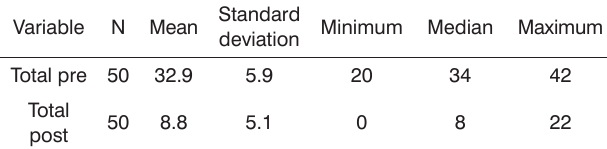
Table 1. Descriptive statistics for total HHIE scores before and after the